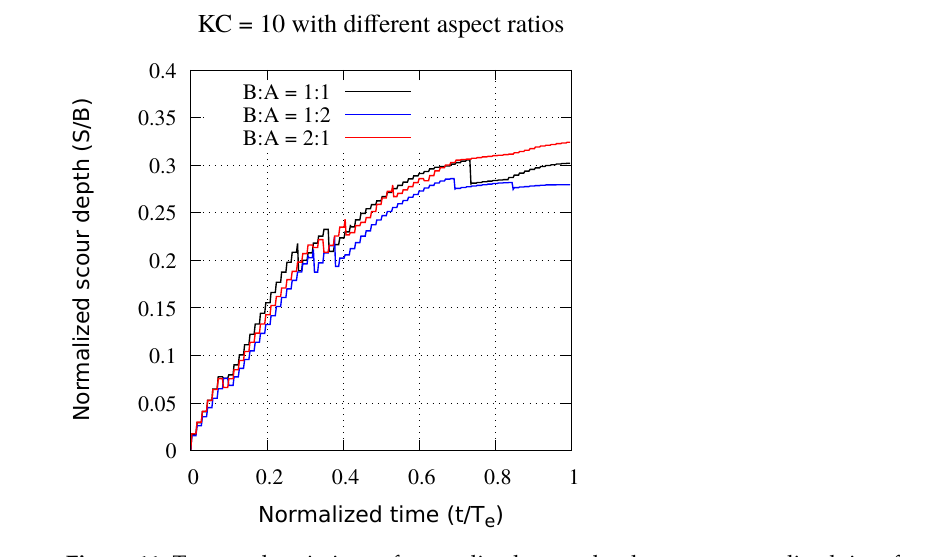
Figure 11. Temporal variations of normalized scour depth versus normalized time for KC = 10 in a wave and combined wave–current flows. The wave period (T) is 4.5 s.